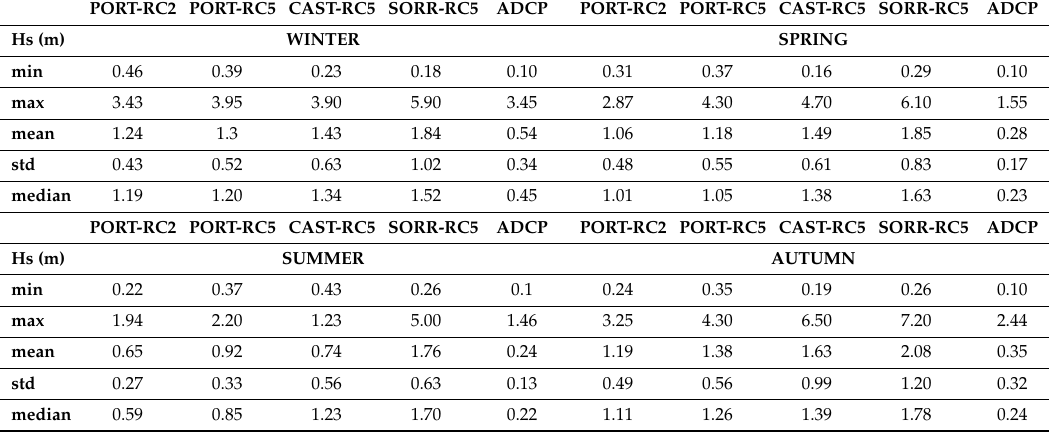
Figure 3. Cumulative seasonal Hs boxplots recorded by the ADCP (T B ) and the HF radars (T HF ). For the PORT site, both RC2 and RC5 data are shown. The panels show the different seasons: ( a ) winter; ( b ) spring; ( c ) summer; and ( d ) autumn. Table 2. Statistical descriptors (min: minimum value; max: maximum value; mean: mean value; std: standard deviation; median: median value) of the seasonal Hs values recorded by the HF radars and the ADCP. For the PORT site, both RC2 and RC5 are included.